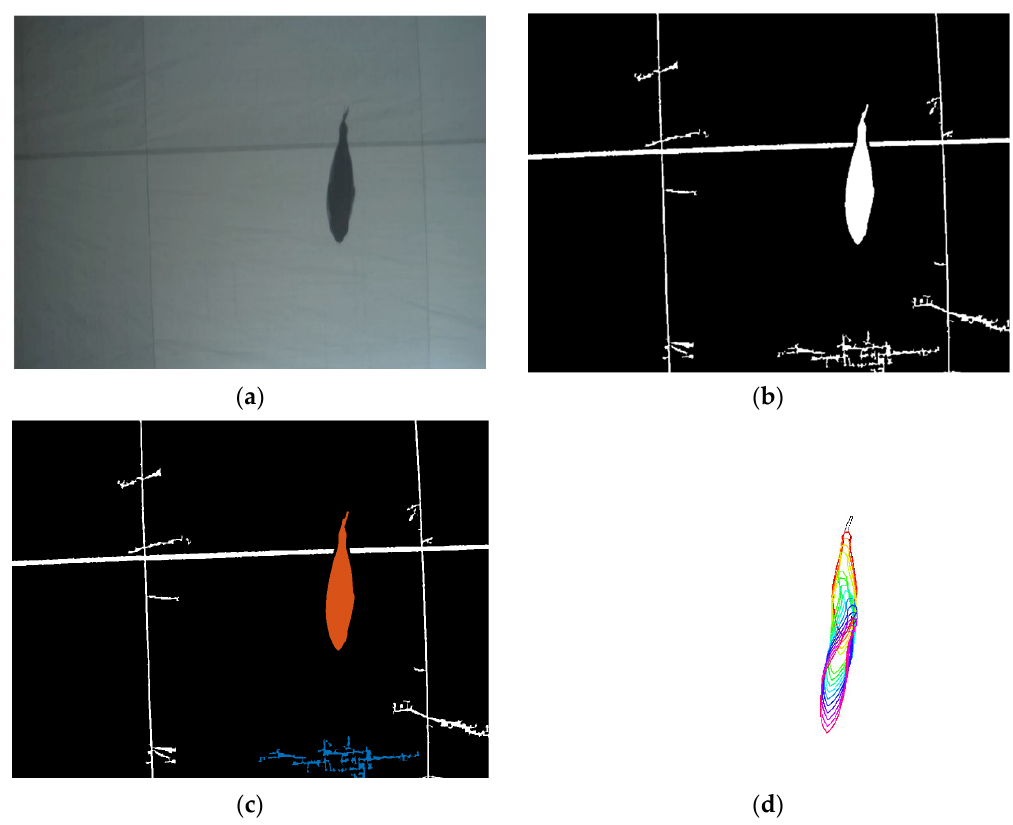
Figure 7. Optical data processing. ( a ) Original image, ( b ) segmented image using local thresholding and morphological operations, ( c ) blob labelling and filtering, and ( d ) tuna model fitting and visual tracking.